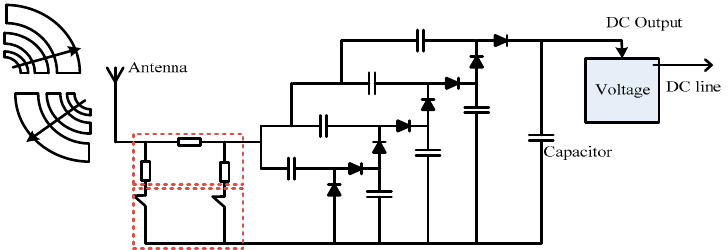
Figure 22. n-stage rectifier circuit model of electromagnetic energy harvesting system [122].